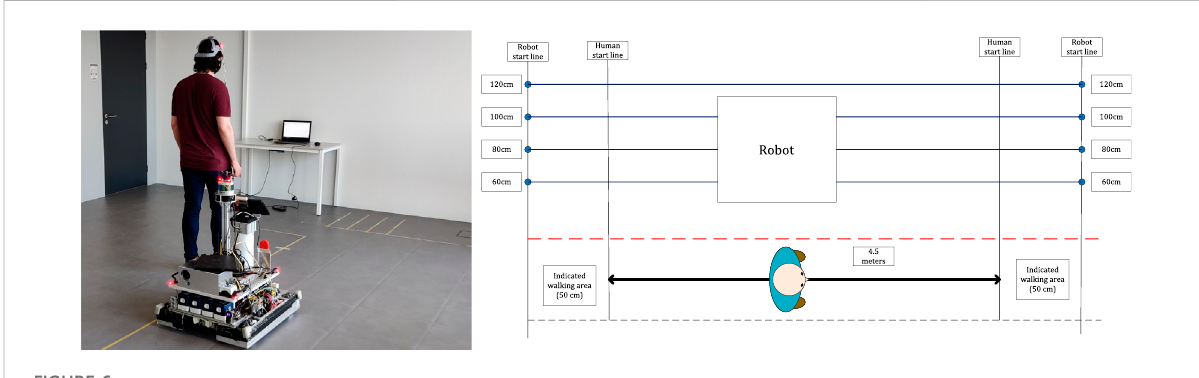
FIGURE 6 Overview of the experimental setup. On the left side of the experiment room, the participant and robot are shown. One of the laptops where peoplecould fi llinthequestionnaireisvisibleonthepicture.Therobothaddifferentstarting positionsasindicatedbythecirclesinthesub- fi gure on the right side with the passing distances of the robot indicated next to